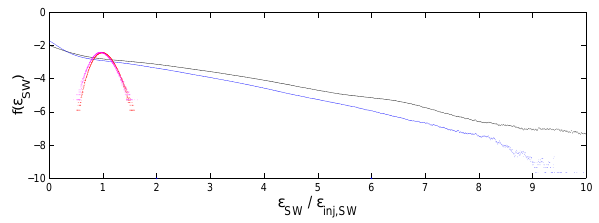
Fig. 9. Solar wind proton energy distribution functions, kinetic en- ergy normalised to E inj , SW vs. normalised frequency on a log 10 scale. Results are shown both in the absence of pickup protons (black) and with 10% pickup protons (blue). For comparison, the upstream distribution functions are also shown, in the absence of pickup protons in red and with 10% in magenta.